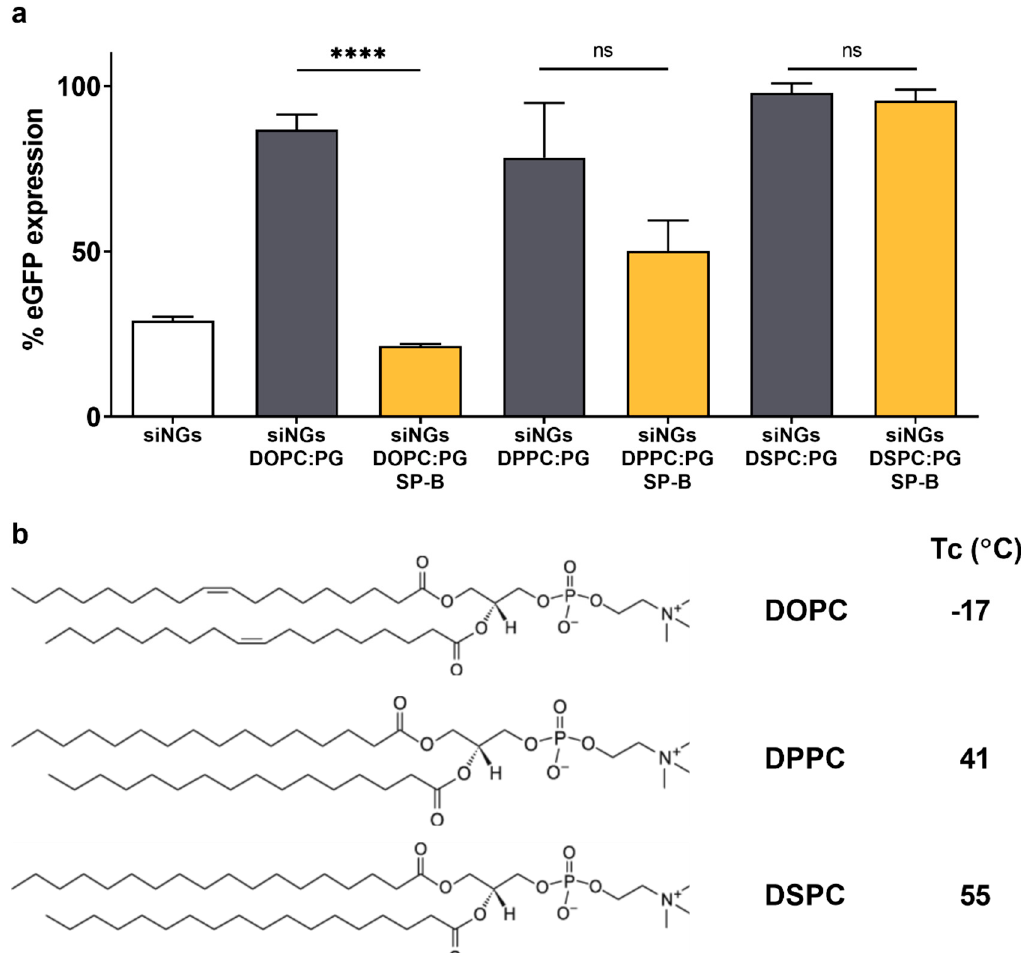
Figure 3. Impact of lipid phase transition temperature on formation and delivery efficiency of SP-B containing proteolipid-coated nanogels. ( a ) Evaluation of eGFP silencing in H1299_eGFP cells by uncoated or (proteo)lipid-coated siNGs with different lipid mixtures, supplemented with 0.4 wt% SP-B. All experiments were performed with a fixed NG concentration (30 μ g/mL) and siRNA concentration (50 nM). The SP-B effect is strongly influenced by the type of lipid with which it is combined, highlighting the importance of a fluid lipid membrane in the formulation of the core-shell nanocomposites. ( b ) Chemical structures and phase transition temperatures (Tc) of the different PC lipids tested. Statistical analysis was performed via an unpaired t -test. Data are represented as the mean ± SD ( n = 2) and statistical significance is indicated (**** p < 0.0001, ns = not significant).